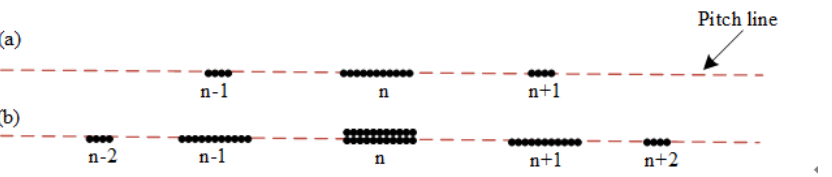
Figure 10. Experimental setup 1,7—active motor, 2,5—coupling, 3,6—torque speed sensor, 4—gear- Figure 10. box, 4.1—drive gear, 4.2—driven gear, 4.3–4.5—three-phase acceleration sensor.